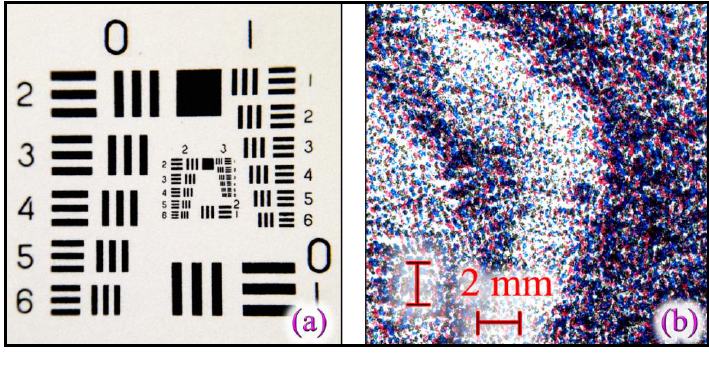
Figure 8. ( a ) SAF 1951 resolution target acquired with an iPhone 5 and an Olloclip ® macro 10× lens mounted on it. ( b ) Particular of Giovanni Job’s Dog lithograph acquired under the same